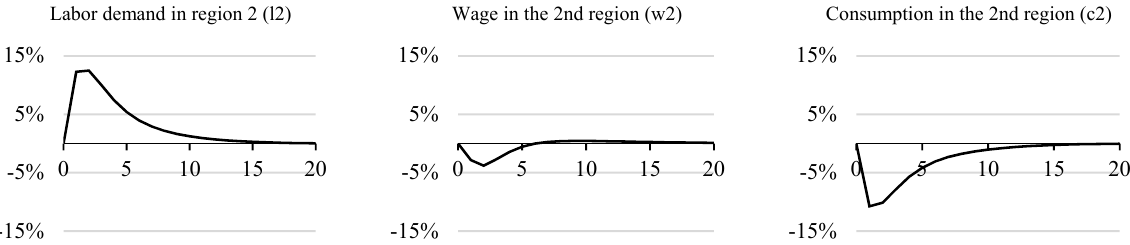
Figure 11. Employment growth, reduction in wages, and consumption in the second region. Finally, the capital market of the second region (Figure 12) shows a “displacement effect”—the growth of budget purchases increases the interest rate and reduces investment. The increased need for capital at first is covered by its import from the first region due to interest arbitration (in the second region, the percentage increases, while in the first region, it initially decreases).